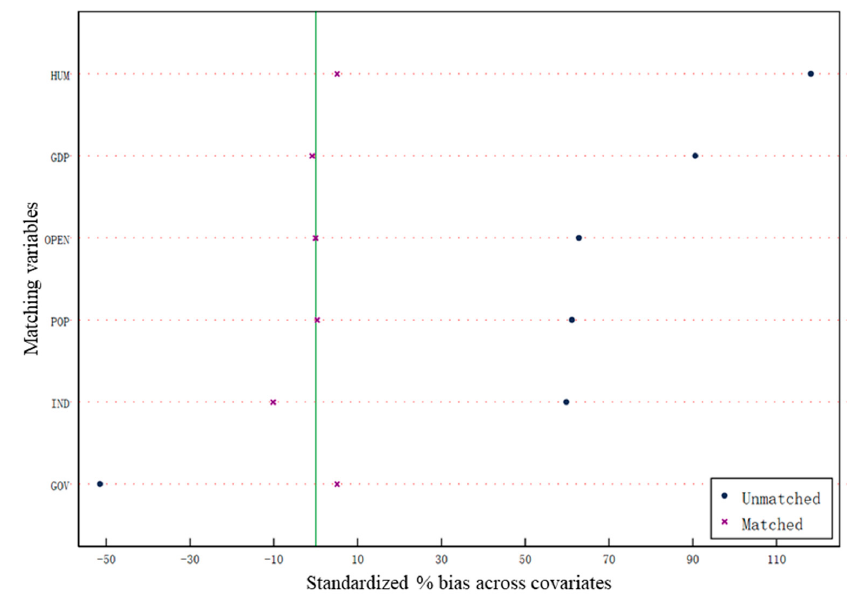
Figure 5. PSM balance test results. Table 4. PSM-DID estimation.